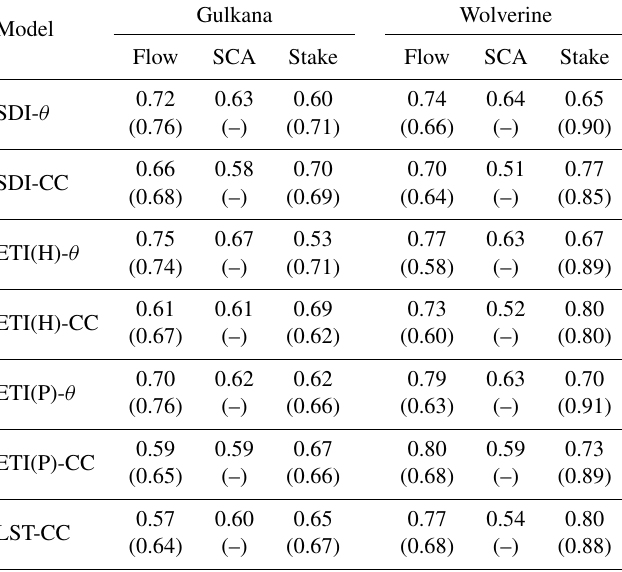
Table B3. Best model evaluation scores during calibration. The top row for each model is 1 minus the PBE score for the “SCA” columns and the KGE score for the “flow” and “stake” columns; the bottom row is the NSE score.